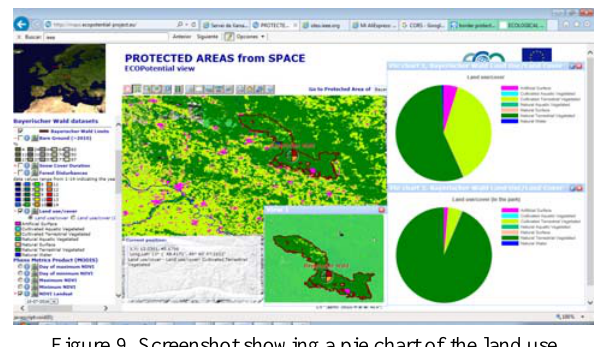
Figure 9. Screenshot showing a pie chart of the land use categories of the Bayerischer Wald Park considering the surroundings of the park (upper part) and only the park area (lower part).